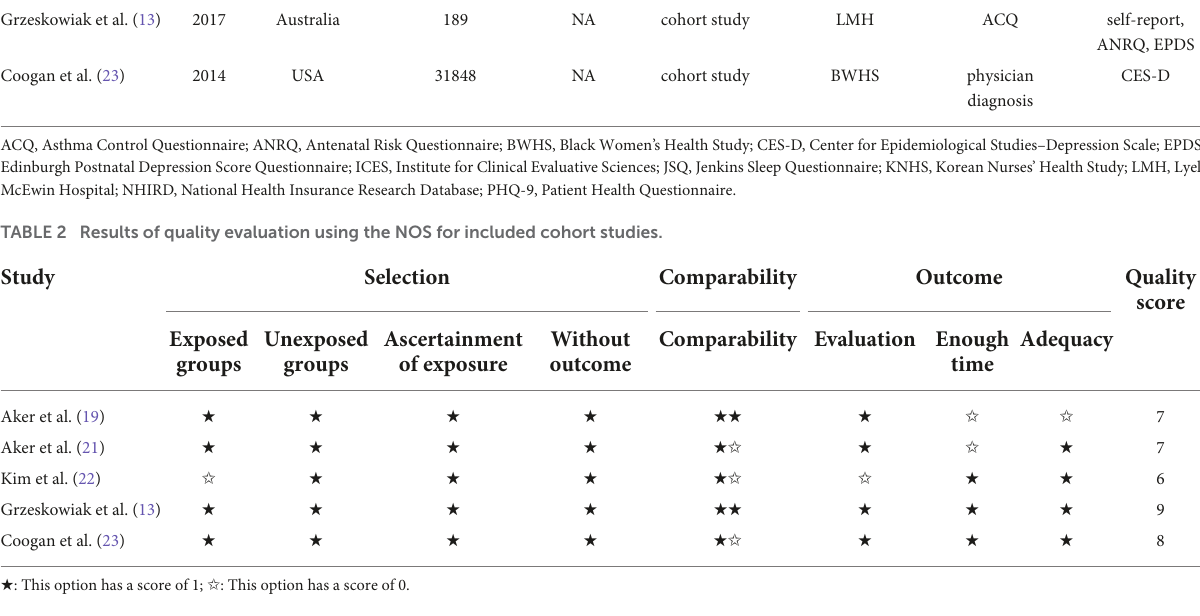
TABLE 3 Results of quality evaluation using the NOS for included case-control